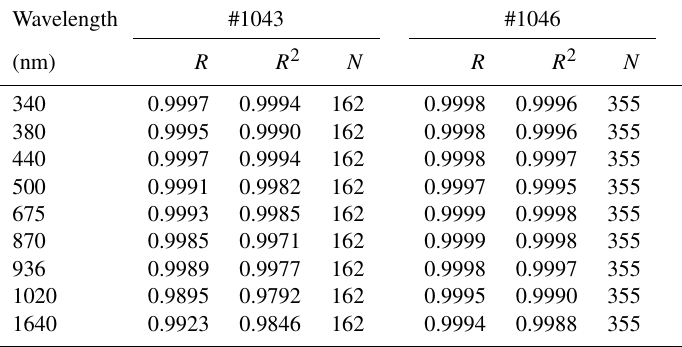
Table 3. Coefficient of determination ( R 2 ) and number of coincident data ( N ) for the raw digital count comparison between CW193 and CE318 measurements for the nine spectral bands used in this